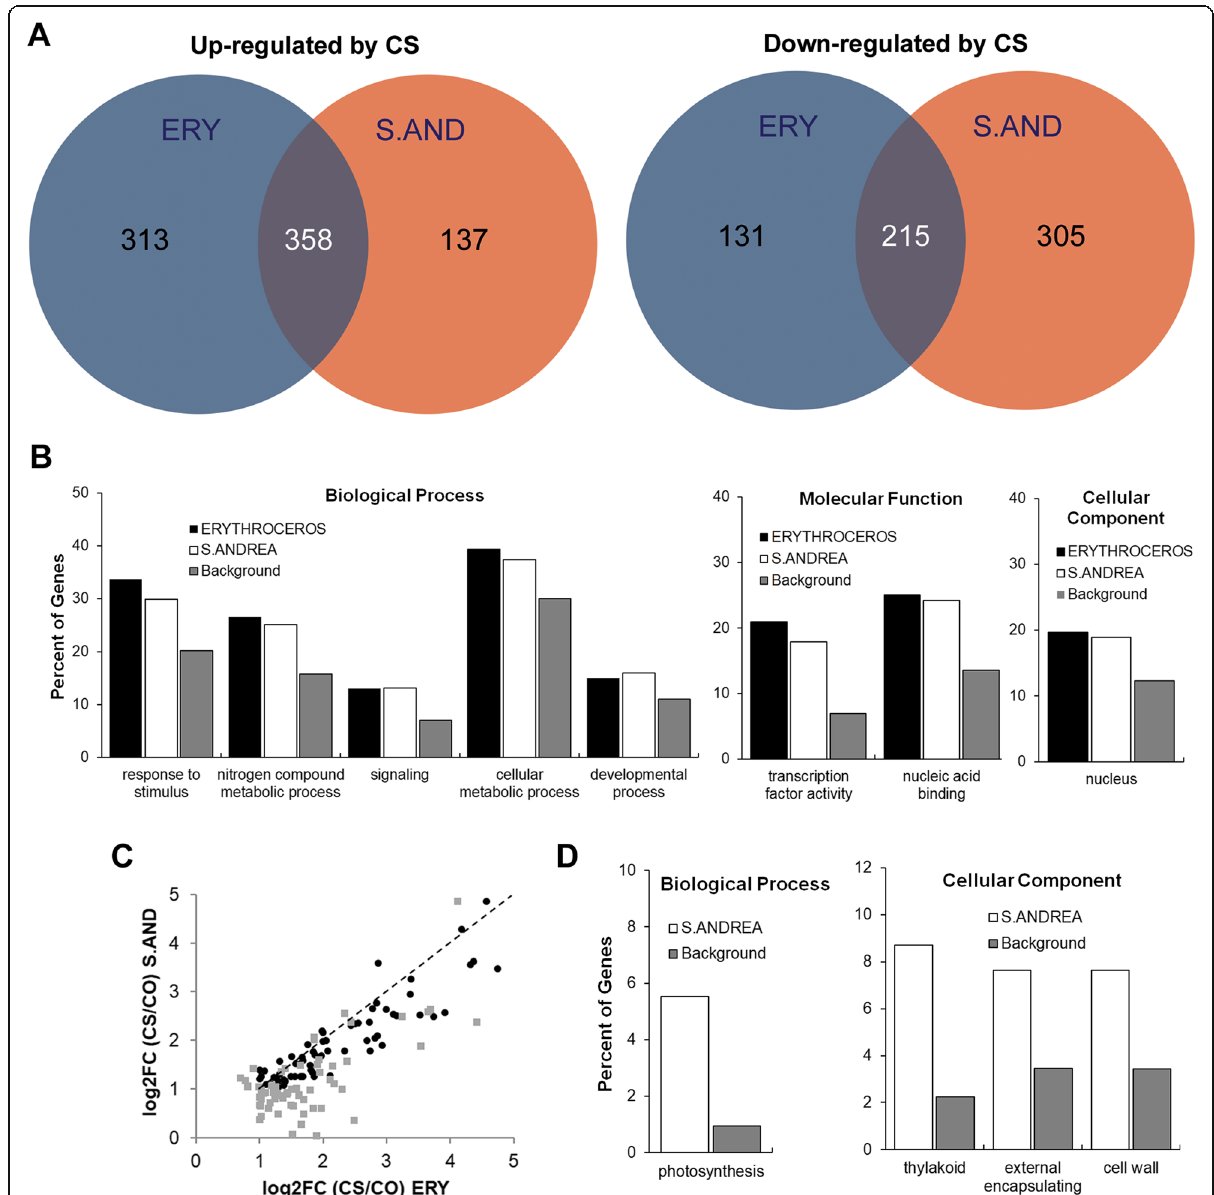
Fig. 2 Gene ontology enrichment analysis of RNA-seq datasets. ( a ) Venn diagrams showing shared deregulated genes from cold-stress RNA-seq datasets. The most representative GO accessions are shown for ERY and S.AND upregulated ( b ) and for S.AND downregulated ( d ) genes by cold stress. Backgrounds correspond to percent of genes from the whole genome belonging to each GO accession. The full list of statistically significant (FDR < 0.05) GO accessions enriched is listed in Additional file 6: Table S2. c , scatterplot of log 2 FC from deregulated transcription factors in cold-stress ERY and S.AND anthers. Black circles correspond to SSTF (statistically significant by two-fold) genes in both cultivars, while grey squares correspond to genes in only one